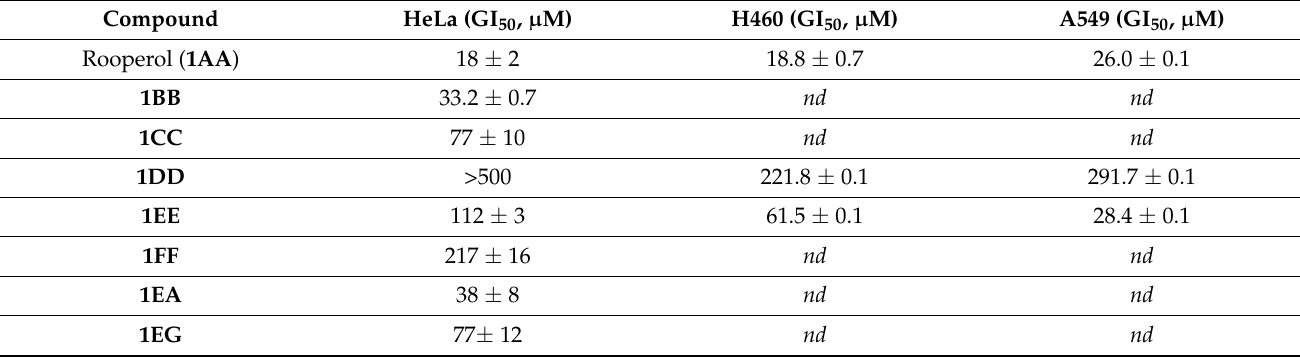
Table 1. Cancer Cell Cytotoxicity of Rooperol and